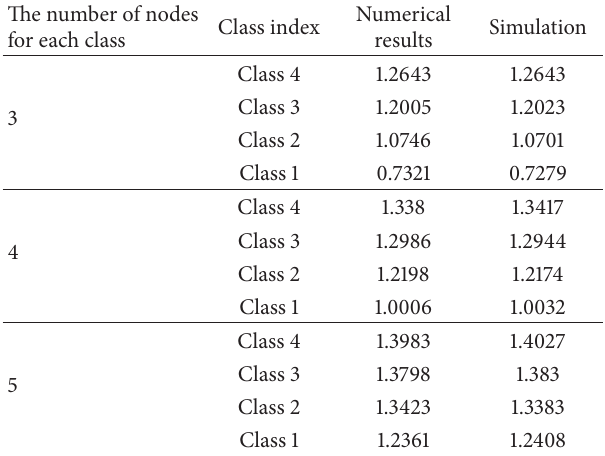
Table 2: Comparisons between numerical and simulation results on latency (unit: